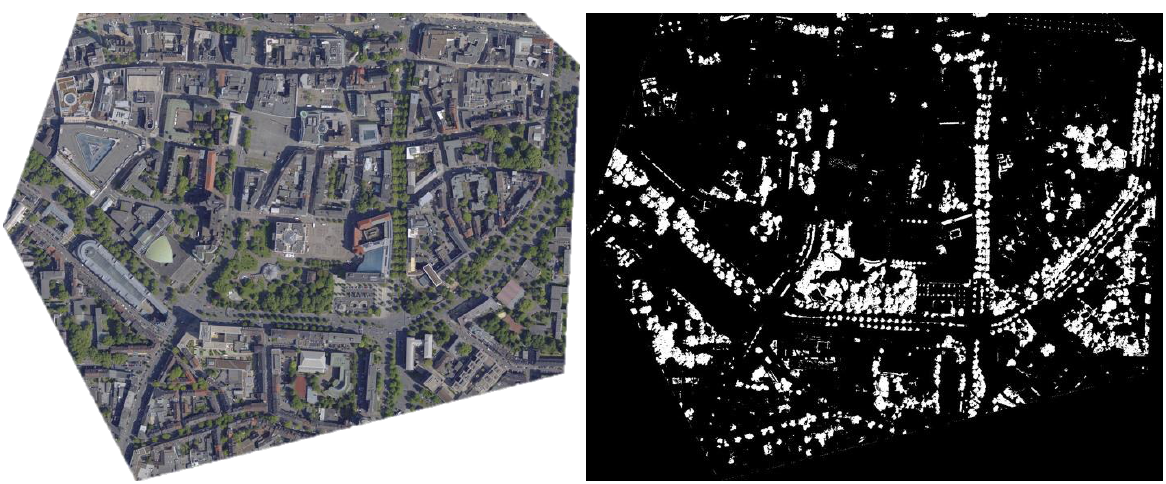
Figure 4. Original orthophoto (left) and the created mask (right) for Dortmund City Center.